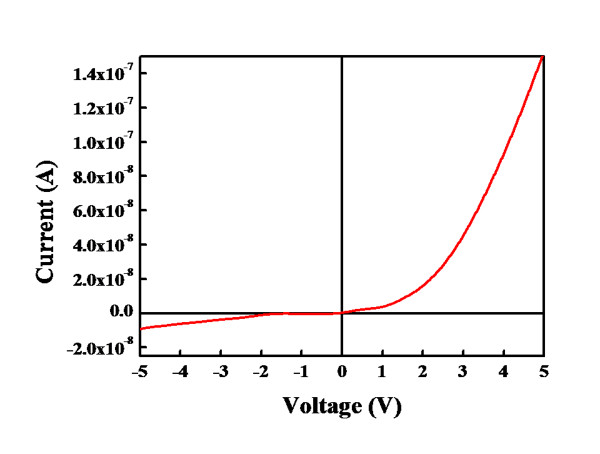
Dark I-V characteristic measured from the fabricated radial p-Cu2O/n-TiO2 nanowires.